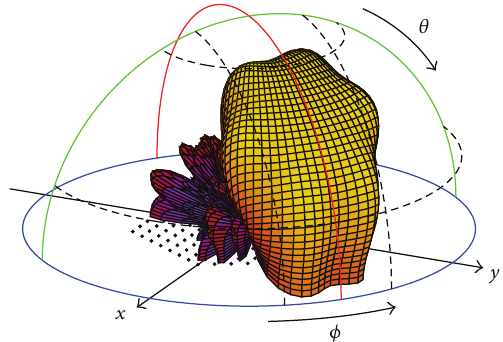
Figure 16: Coverage after steering the SHA-169 𝑆 𝑓 pattern to (50 ∘ , 35 ∘ ) .